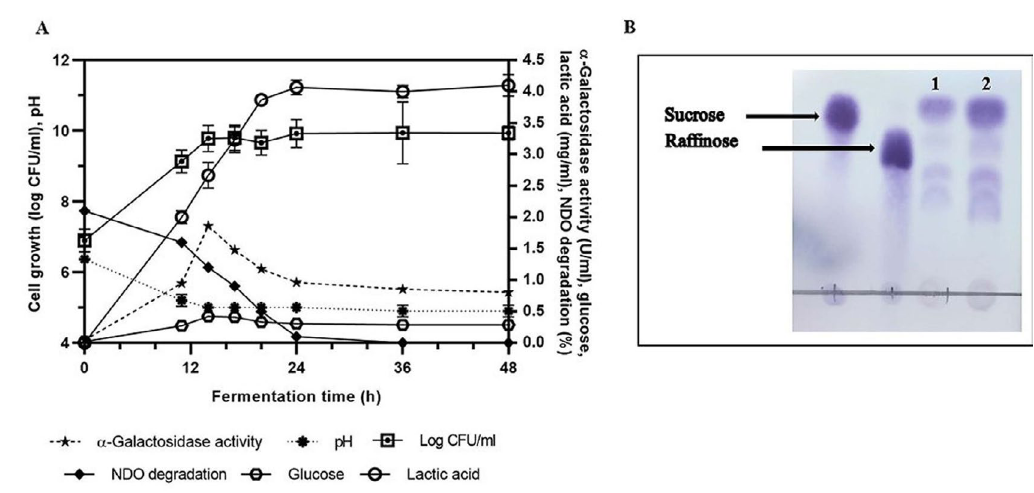
Fig. 5. Change in pH reduction, bacterial growth, residual sugars, lactic acid and a-galactosidase activity during fermentation with pigeon pea bean by L. brevis (A). Chromatogram (TLC) separation pattern of non-digestible oligosaccharides in untreated (control) and L. brevis treated pigeon pea bean. Lane 1: 18-h-treated pigeon pea, Lane 2: untreated pigeon pea bean (B). Experiment was done in